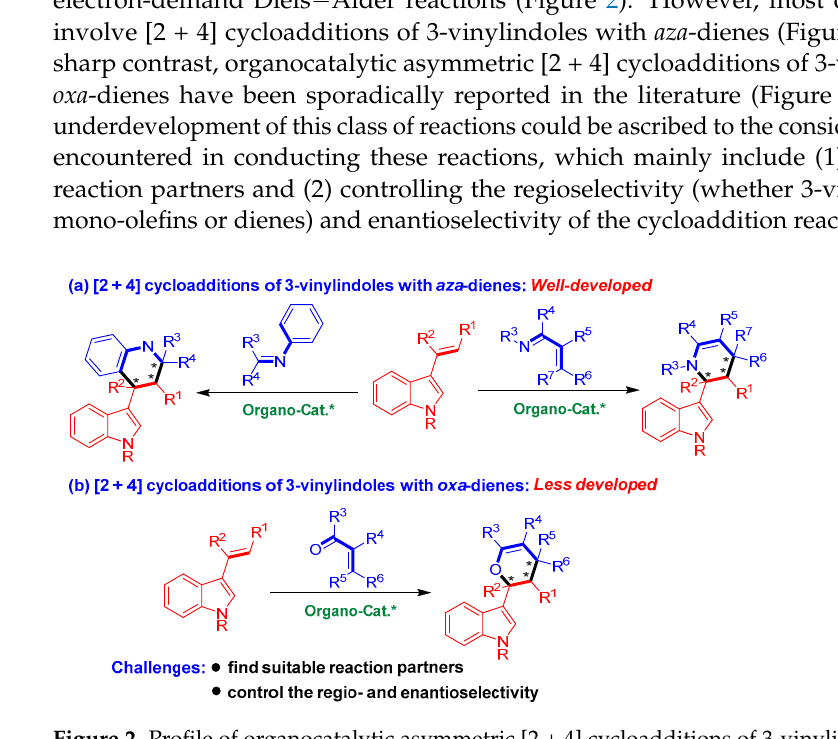
Figure 2. Profile of organocatalytic asymmetric [2 + 4] cycloadditions of 3-vinylindoles. The asterisk * indicates chiral center.